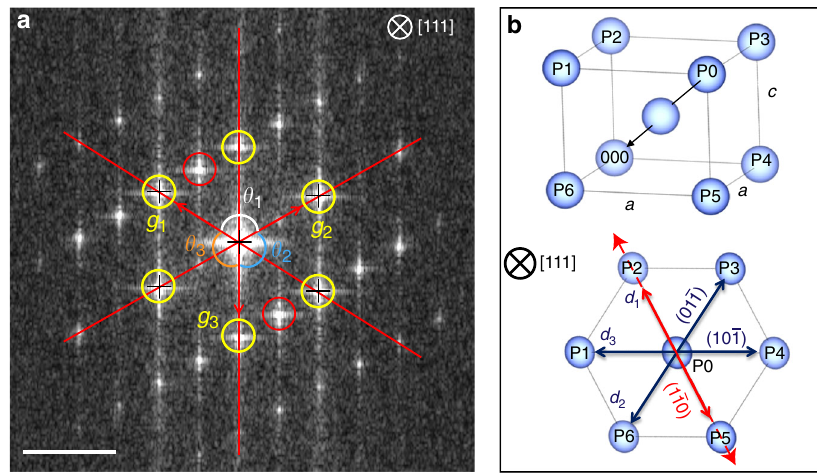
Fig. 3 Determination of Ru lattice parameters. a FFT of the 6 nm Ru fi lm along the [111] zone axis, from indicated region of Fig. 2b, with the expected BCT grouping highlighted in yellow, and distortions in the tetragonal ordering are highlighted in red. Scale bar is 5 nm − 1 . b The expected [111] zone axis projection for BCT Ru, and by using the measured interatomic spacing and atomic plane angles, an estimate of c/a for a BCT structure can be calculated. The dashed red line shows the orientation of the lattice distortion